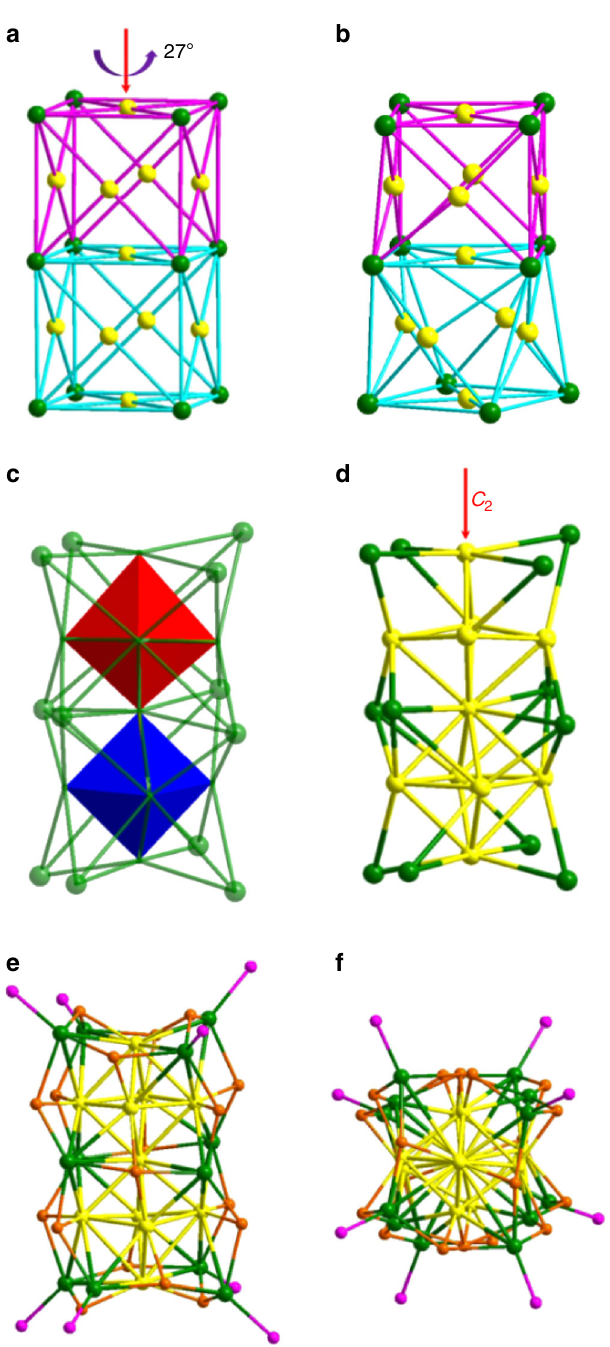
Fig. 2 Anatomy of the twisted structure of Ag 23 (PPh 3 ) 8 (SC 2 H 4 Ph) 18 nanocluster. a Ideal structure of 1 × 1 × 2 supercell of fcc packing mode. The face centers and vertices of the unit cells are shown in yellow and green, respectively. b Twisted supercell observed in the Ag 23 nanocluster, in which the two fcc unit cells are twisted by ca. 27 ̊ with respect to each other, resulting in a helical structure. c Two rhombic bipyramids within the nanocluster are highlighted by blue and red facets. d Total framework of Ag 23 with C 2 symmetry. e and f show the total framework of Ag 23 S 18 P 8 (top and side views). Color labels: S, orange; P,